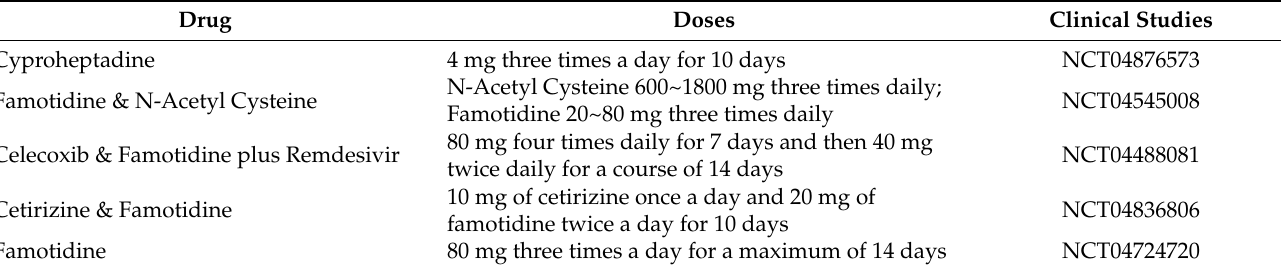
Table 2. Examples of histamine (H1/H2) receptor antagonists repurposed for COVID-19.